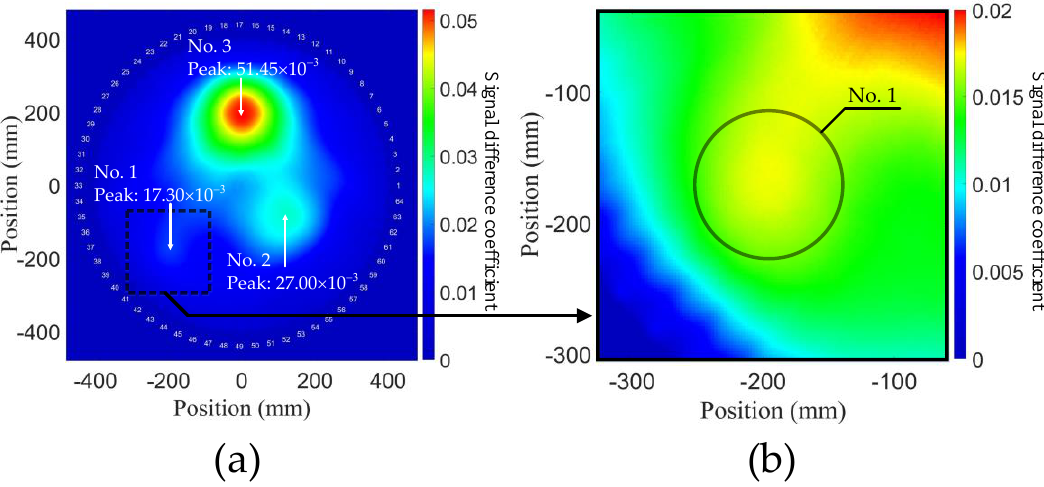
Figure 11. Probability distributions of aluminum plate model with early-life material degradations, using NGW method expressed with the third harmonics. ( a ) Reconstruction containing all degradations. ( b ) Zoom in on the square region around degradation No. 1 shown in ( a ).